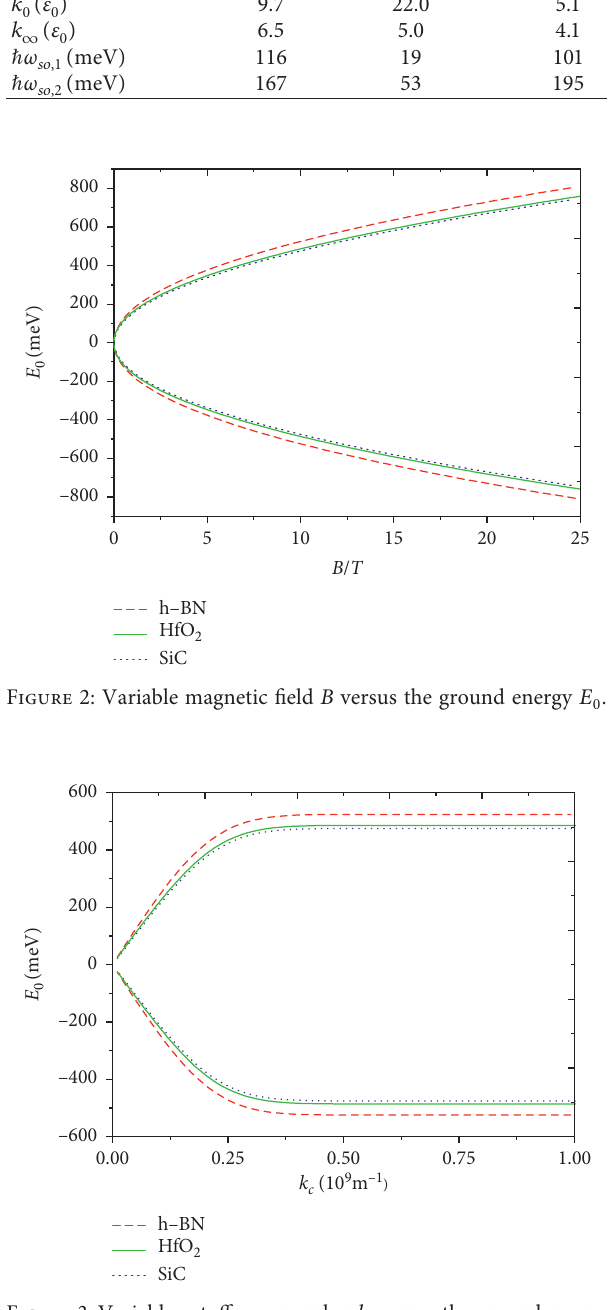
c versus the ground energy